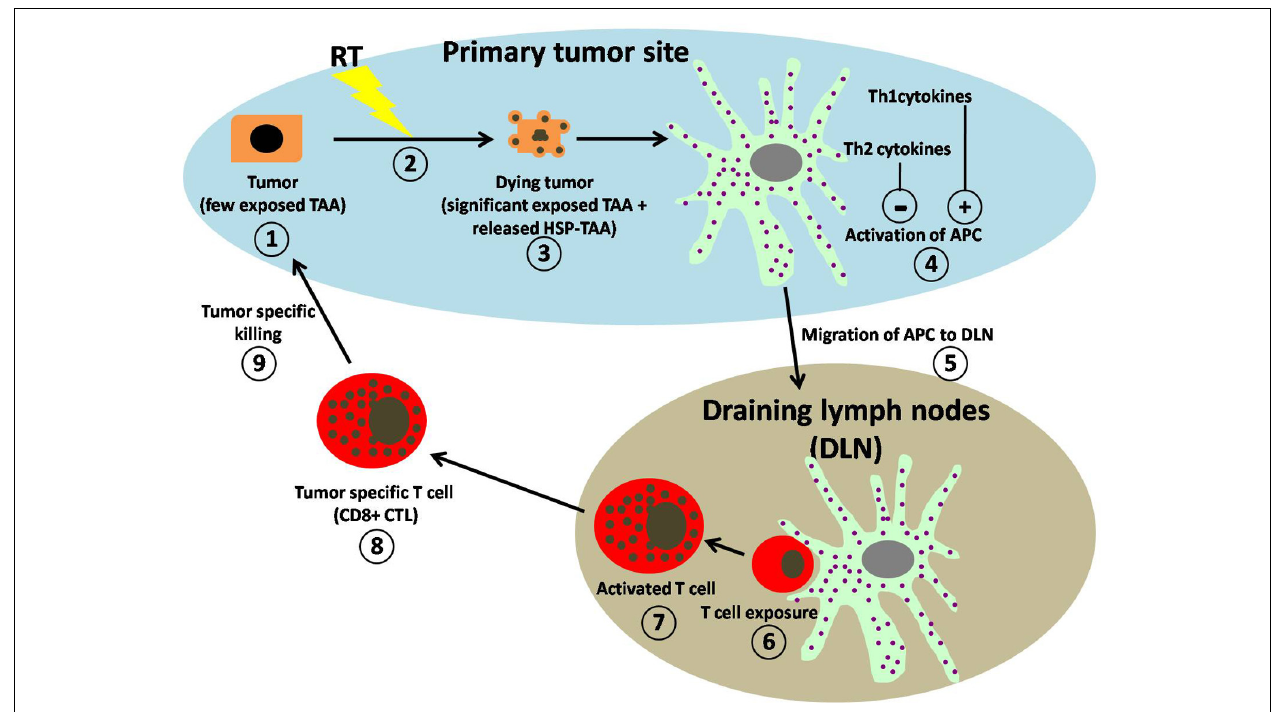
FIGURE 1 | Schematic representation of working hypothesis for RT-induced anti-tumor immune regulation. (1)Within the primary tumor microenvironment (blue area) untreated tumors express few exposed tumor-associated antigens (TAAs). (2) Exposure to RT induces the (3) dying tumors to express significantly moreTAAs on their surface and to release DAMPS, (4) which are both taken up by professional APCs resulting in their activation. Activation of APC is greatly enhanced ( + ) by the presence of